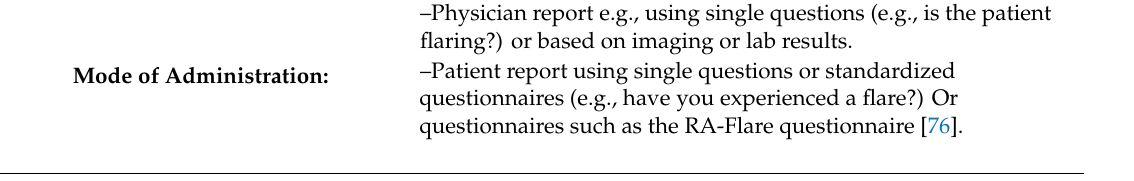
Table 2. Methods to assess disease flares in rheumatic diseases.